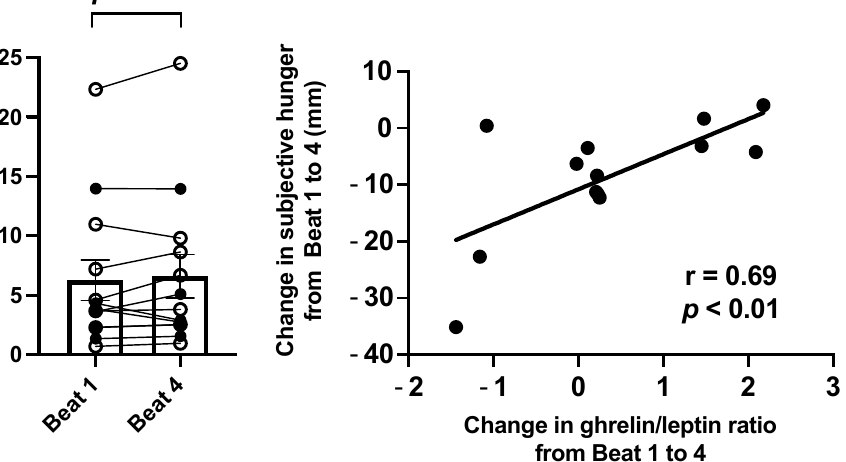
Figure 5. Impact of circadian disruption on ghrelin/leptin ratio and the relationship between the change in subjective hunger on a visual analog scale and the change in fasted ghrelin/leptin ratio across chronic circadian disruption (Beat cycle 1 to Beat cycle 4). Data from the Control ( n = 8, 1:2 sleep:wake ratio) participants are denoted by open circles and those from the Chronic Sleep Restriction (CSR, n = 9, 1:3.3 sleep:wake ratio) participants are denoted by closed circles in the ( right ) panel. Beat cycles (i.e., time to complete a cycle of circadian and sleep:wake schedule combinations, which was ~6 protocol days in this forced desynchrony design) of the protocol are shown on the x -axis. Group means for each beat cycle are denoted by the open column and error bars represent SEM. p values are derived from independent t -tests used to test differences between Beat cycle 1 and Beat cycle 4. In the ( left ) panel, data points represent individual participants and the solid line represents the linear fit of the data. p values derived from Pearson correlation.